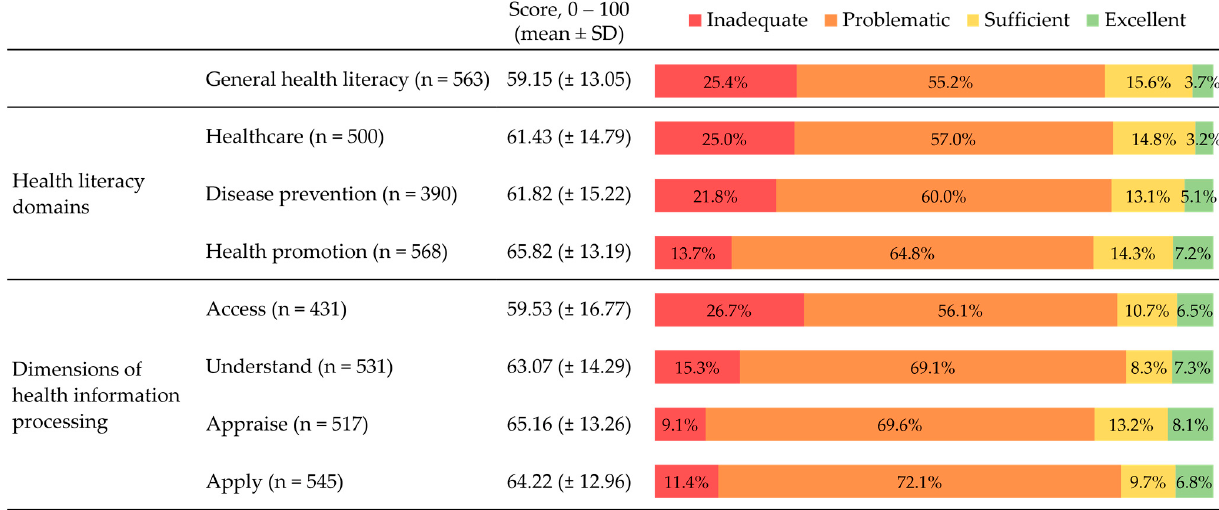
Figure 1. Scores (mean ± SD) and levels (%) of health literacy. The n varies across health literacy measures because it represents the number of participants with at least 80% of valid responses in the items used for calculating each score. SD, Standard deviation.